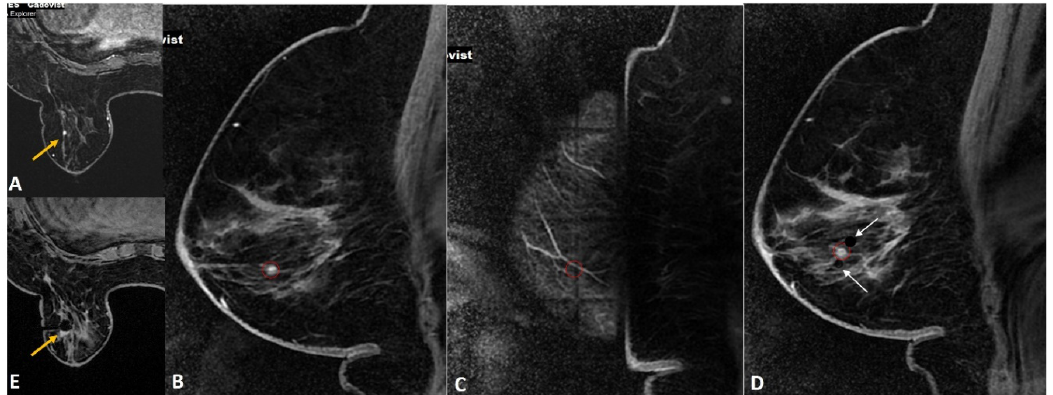
Figure 7. ( A ). High-risk screening in a BRCA 2 woman showed a new 4-mm enhancing focus in the left breast (yellow arrow). ( B ). Sagittal image on the biopsy day showed the target focus enhancing well (red circle). ( C ). During targeting, the entry point was noted to fall on the “cross” of the grid (red circle), which blocked the ideal entry site. ( D ). In this case, we performed dual-needle targeting though diagonally adjacent holes. Two obturators in these holes (white arrows) are seen adjacent to the target (red circle). Selected directed sampling through both these needles towards the target would increase the chance of getting the tiny lesion biopsied adequately. ( E ). Post biopsy hematoma cavity (yellow arrow) was seen at the target site with non-visualization of the target suggesting adequate sampling. The histology was proven as 3-mm invasive tubular carcinoma. Figure 8. ( A ). Screening MRI in a high-risk patient showed a new indeterminate focal non-mass enhancement (yellow arrow) in left breast. ( B ). During the biopsy, the enhancing lesion (yellow ar- row) was seen compressed and pushed along posterior aspect. ( C ). The lesion (yellow arrow) was displaced medially by the obturator of the biopsy guide. ( D ). The needle was pushed beyond the target and then withdrawn to correct depth (yellow arrow). This strategy helped to place the needle